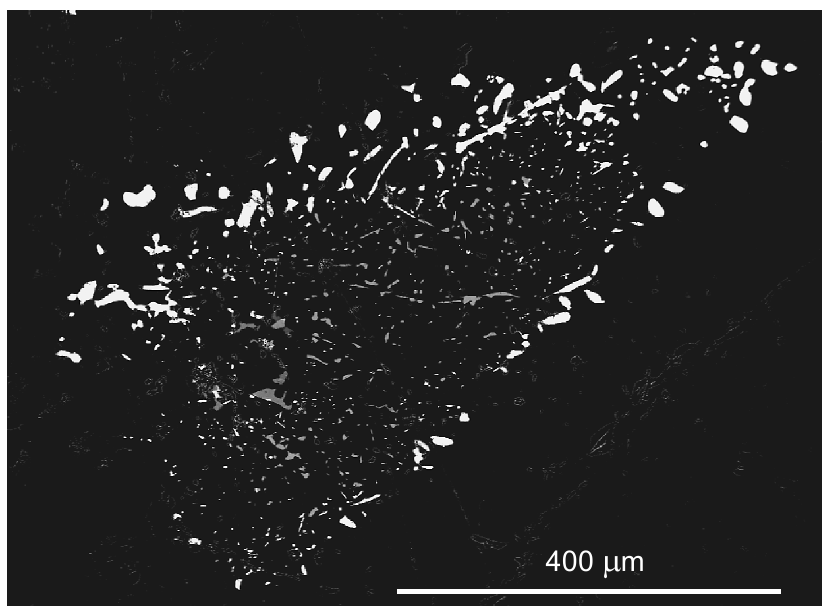
Figure 21. The inclusions of Bi-rich chalcostibite (grey) and Sb-rich bismuthinite (white) in tetrahedrite-(Fe) (black). BSE photo.